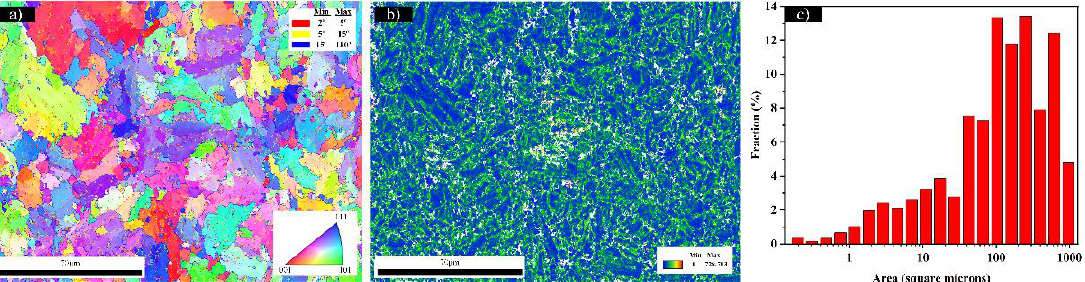
Figure 17. Microstructure information of sample D. ( a ) EBSD orientation map; ( b ) GND map; ( c ) grain area distribution.